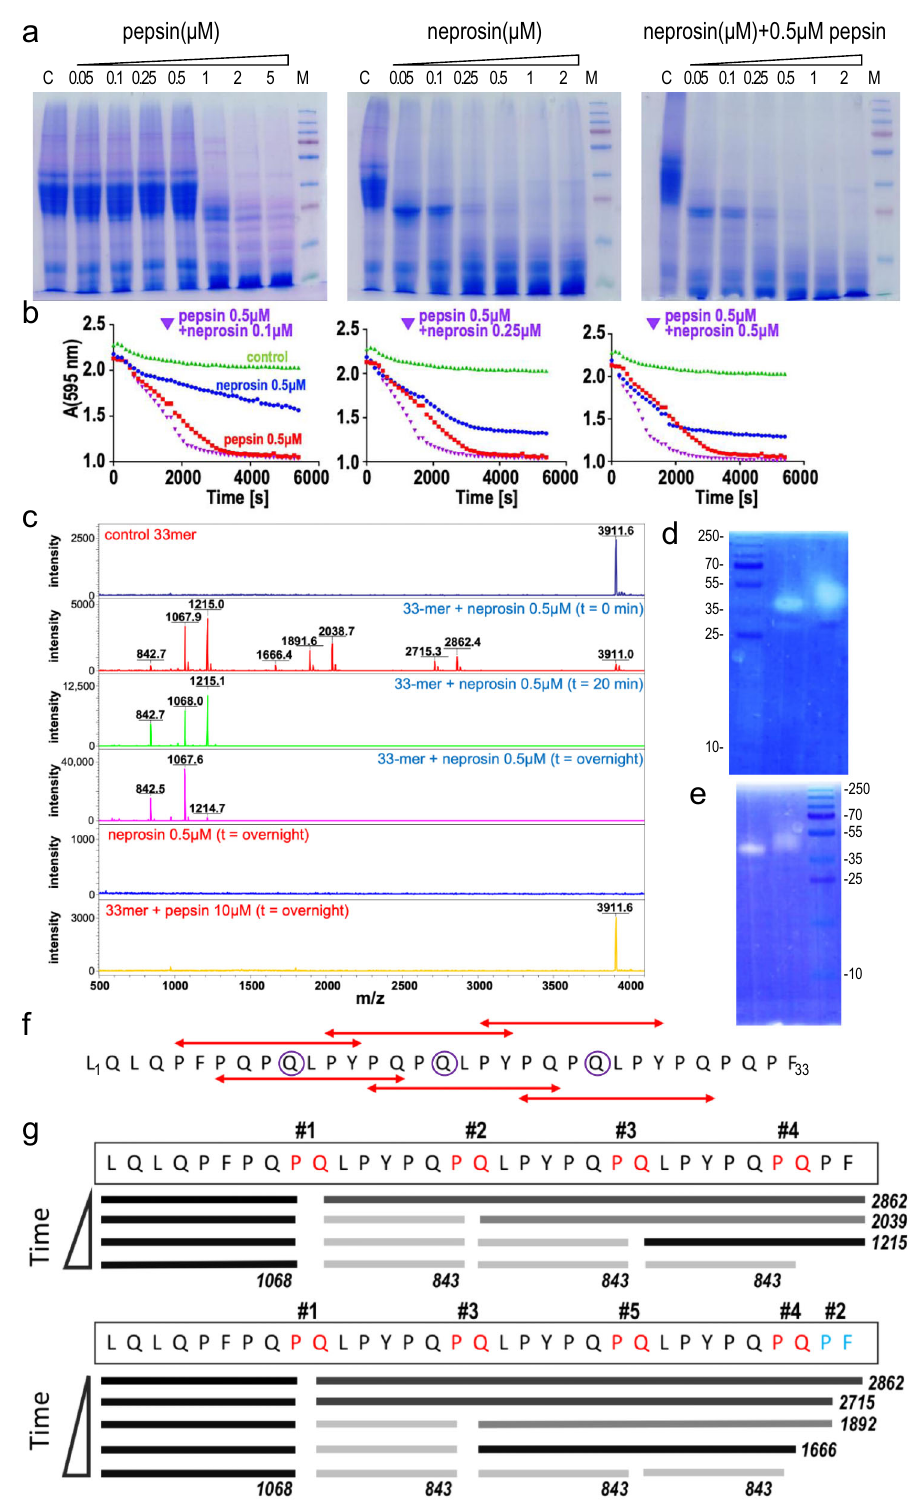
Fig. 3 | Neprosin activity against molecules relevant for coeliac disease. a SDS- PAGE analysis of gliadin exposed to increasing concentrations of pepsin (left), neprosin (centre) or neprosin plus pepsin (right). Figure representative of two independent experiments. b Curves depicting gliadin cleavage as in ( a ) over time measured by turbidimetry. c Mass spectra of, top to bottom, the 33-mer peptide (3912 Da); the 33-mer peptide after incubation with 0.5 μ M neprosin for 0min, 20min and overnight; neprosin alone; and the 33-mer peptide after overnight incubationwith10 μ Mpepsin,whichleavesthepeptideintact. d Gliadinzymogram depicting the activity of neprosin (leftlane) andthe matureenzymeresultingfrom